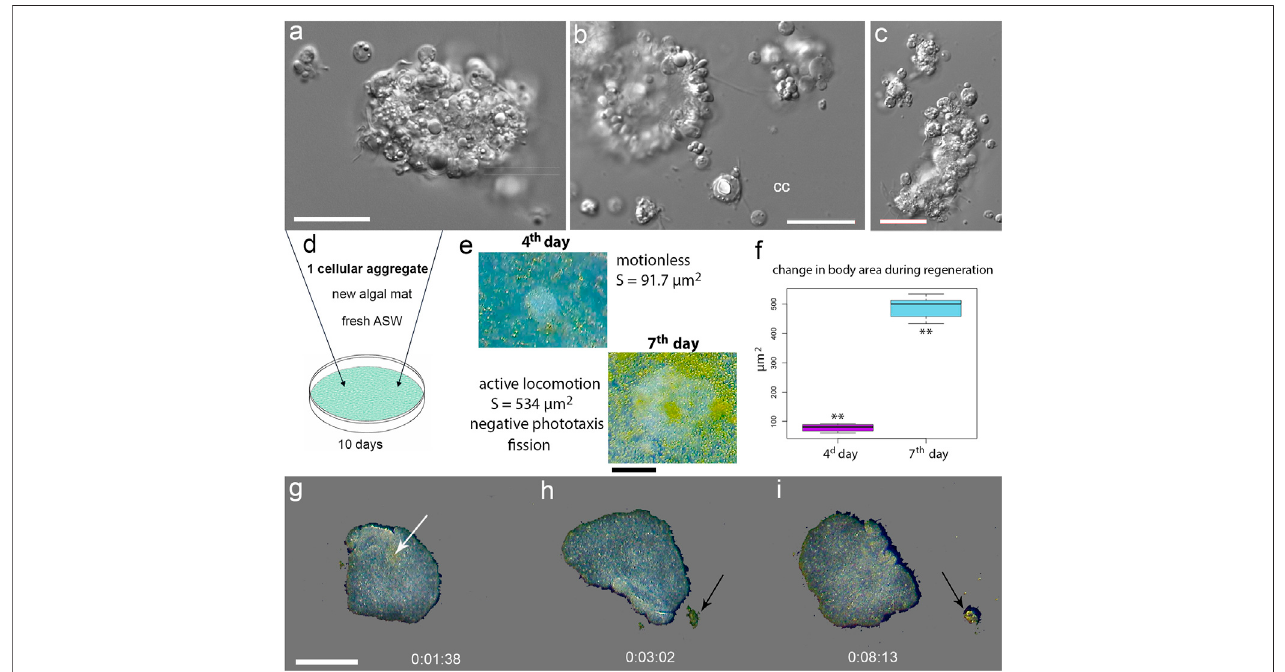
FIGURE 6 | Regeneration in Placozoa. (A,B,C) — Illustrative examplesof small cellular aggregates from T. adhaerens . Aggregates consist of ciliated epithelial cells, lipophil, crystal, and fi ber cells, which were identi fi ed based on their distinct morphology. cc-isolated crystal cell. (D) — Placement of a single aggregate in a new culture cell with fresh ASW and algal mat. (E) — 4th and 7th day of regeneration with calculated surface area (S) of a newly formed animal. The ciliated locomotion, negative phototaxis and fi ssion started on the 7th day of regeneration. (F) — increasing surface areas occurred from 4th to 7th day. The t-value: − 23.48979. The p -value: < 0.00001. (G – I) — time-lapse images after splitting an animal into two parts; locomotion and feeding continued (see text and Supplementary Video S7 ). Arrows indicate a cluster of algae. Scale bar: (A,B,C) — 20 μ m, (E) — 200 μ m, (G – I) — 500